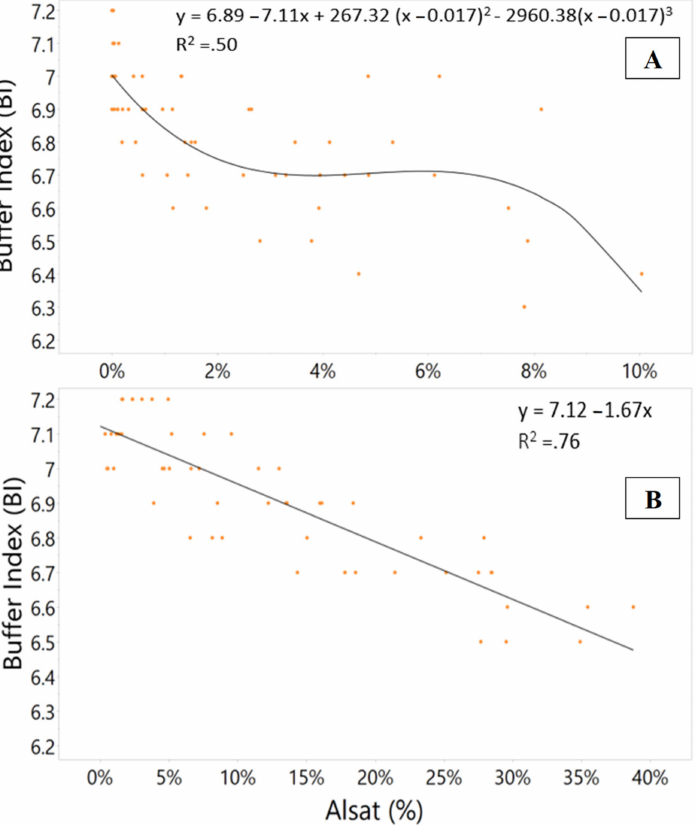
Figure 2. ( A ) Cubic trend among buffer index (BI) and Al saturation (Al sat ) at Chickasha, OK (pooled for Year 1 and Year 2); p < 0.0001. ( B ) The linear trend among buffer index (BI) and Al saturation (Al sat ) at Stillwater, OK (pooled Year 1 and Year 2); p <